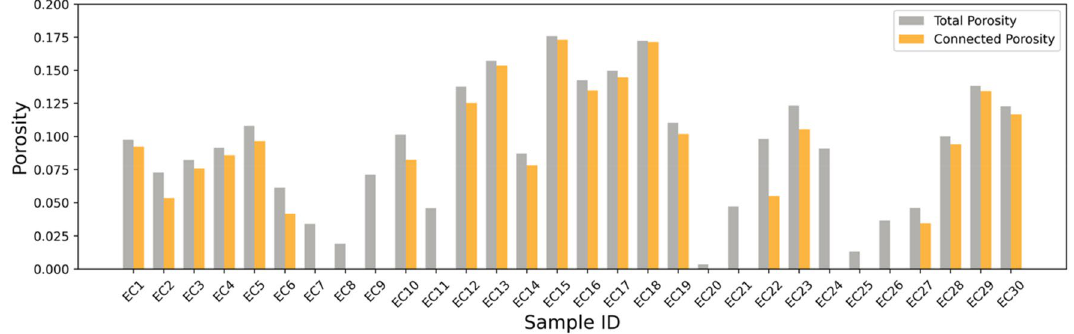
Figure 2. Bar chart showing the range of total and connected porosities across the Otter Sandstone Formation samples collected from the English Channel. A full range of degrees of connectivity are shown from near full connectivity through partial connectivity and no connectivity.